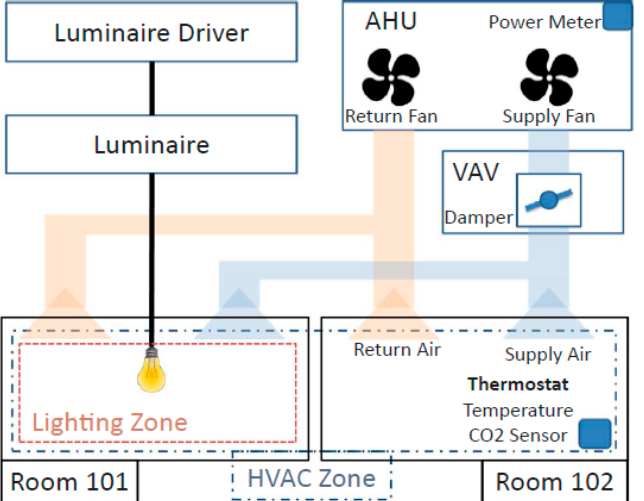
Figure 9. A simple example building that highlights the components to be modeled in a building